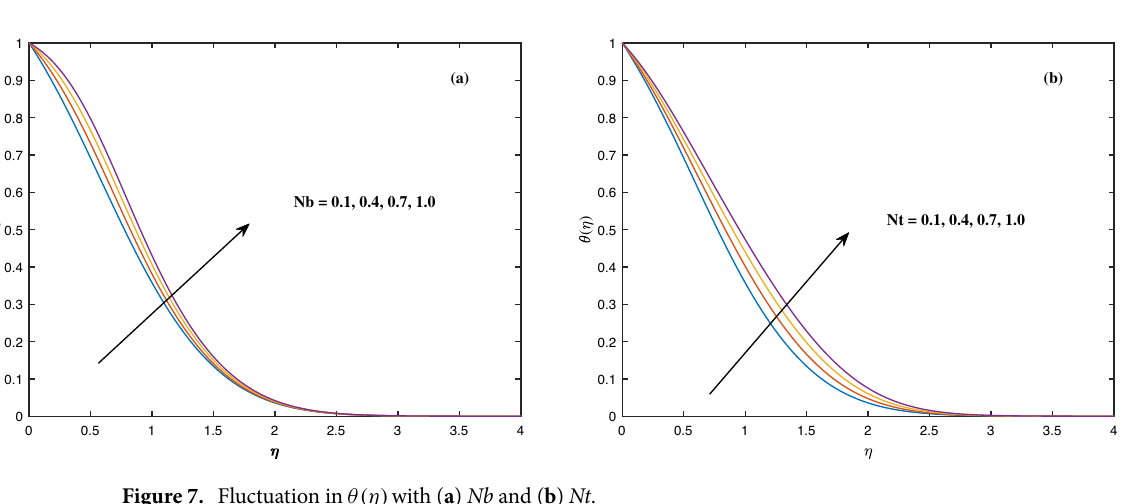
Figure 7. Fluctuation in θ(η) with ( a ) Nb and ( b ) Nt